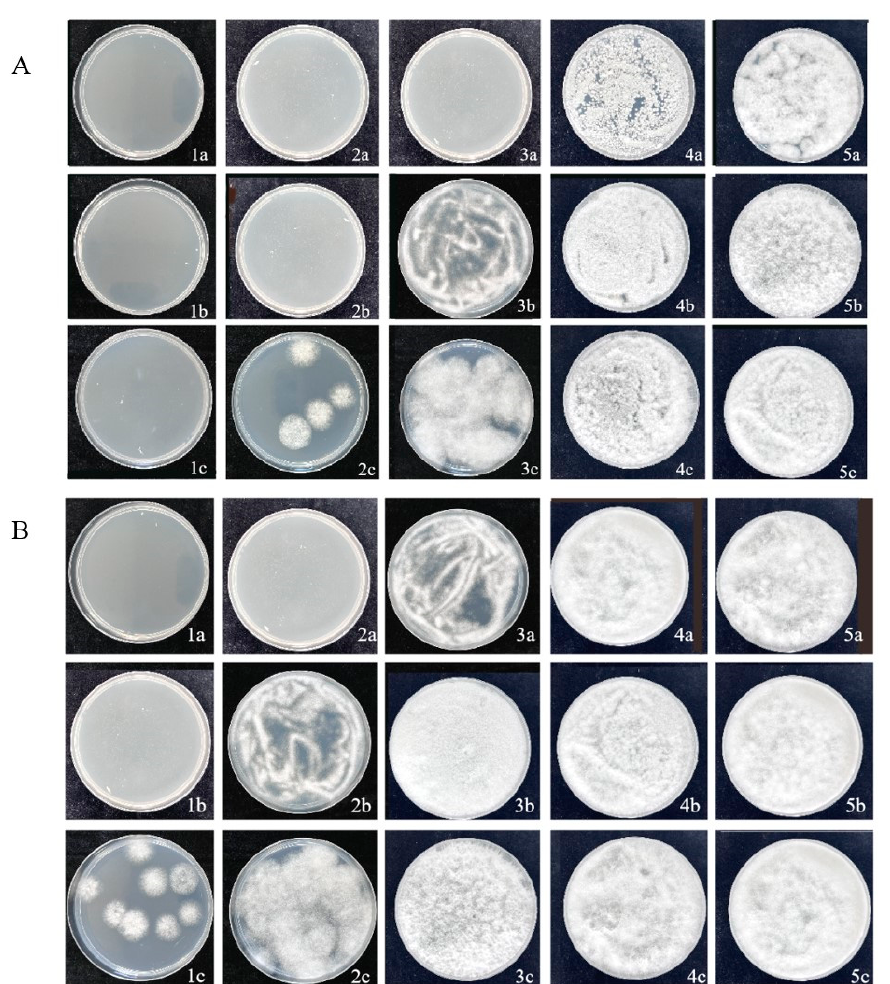
Figure 3. ( A , B ) show inhibitory effects of different volatile components on C. camelliae for 2 and 7 days, respectively; different volatile components are ( a ) geraniol, ( b ) linalool, ( c ) methyl salicylate; different treatment concentrations are (1) 2 mg·mL − 1 , (2) 1 mg·mL − 1 , (3) 0.5 mg·mL − 1 , (4) 0.25 mg·mL − 1 , (5) 0.125 mg·mL − 1 .